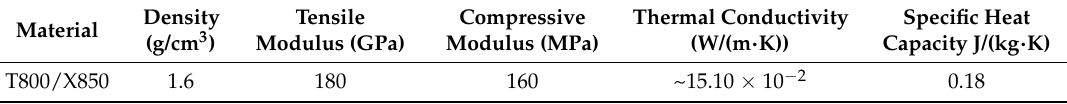
Table 1. Physical properties of the studied T800/X850 CFRP